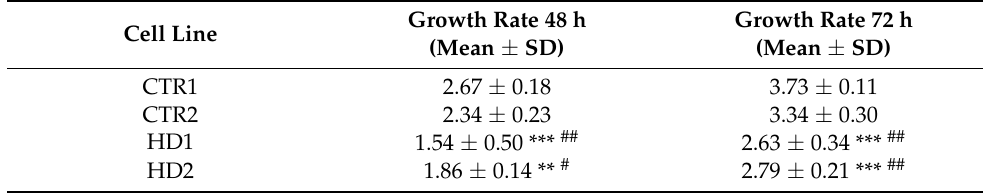
Figure 5. ( a ) Number of CTR1, CTR2, HD1 and HD2 fibroblasts in basal conditions at 0, 48 and 72 h. Data are shown as mean ± SD. ( b ) Percentage of cell death for all cell lines in basal conditions. The box plot represents median, 25 and 75% percentiles, and minimum and maximum values. Fibroblast numbers were determined by direct counting of stained and unstained cells after 48 and 72 h, and plotted against culture time. * p < 0.05, ** p < 0.01, *** p < 0.0001 compared with CTR lines (Two-way ANOVA, followed by uncorrected Fisher’s LSD for multiple comparisons). Table 5. Growth rates of CTR1, CTR2, HD1 and HD2 fibroblasts at 48 and 72 h in basal conditions. Growth rates are shown as mean ± standard deviation (SD). ** p < 0.01 and *** p < 0.0001, compared with CTR1 (Two-way ANOVA, followed by uncorrected Fisher’s LSD for multiple comparisons); # p < 0.05 and ## p < 0.01, compared with CTR2 (Two-way ANOVA, followed by uncorrected Fisher’s LSD for multiple comparisons).